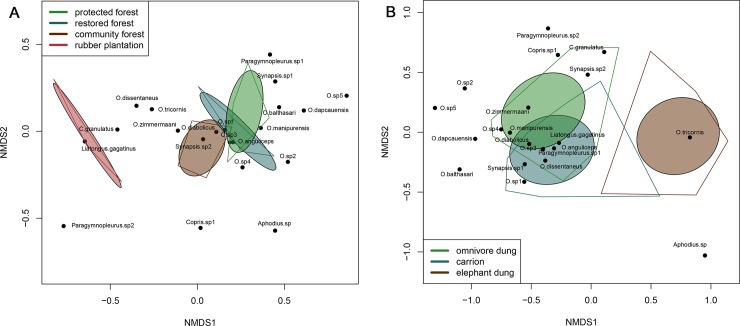
NMDS ordinations of dung beetle assemblages across land-use and bait type categories.NMDS ordinations for assemblages across A) land-use categories (stress = 0.11) and B) bait types (stress = 0.17) using Wisconsin standardization of abundance matrices. Ordinations include standard deviation ellipses (CI = 0.05) and convex hulls enclosing all data points within each grouping level (land-use category, bait type, respectively).